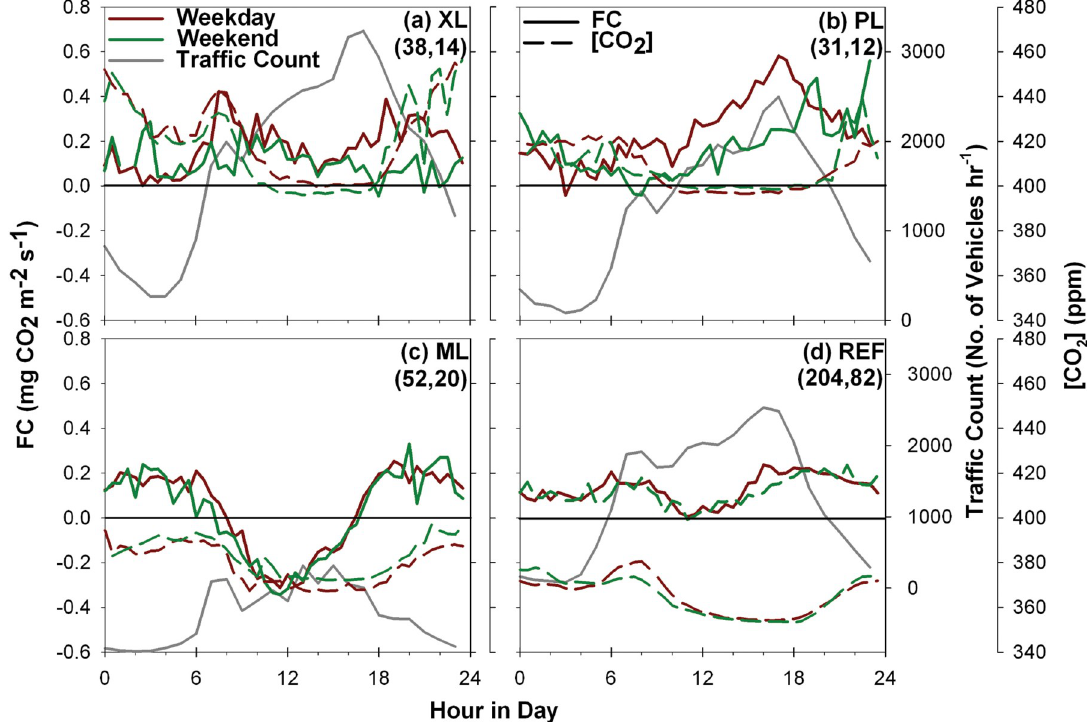
Fig 6. Diurnal averages of FC for weekday and weekend days. Comparison of the average diurnal cycles of carbon dioxide flux for weekday and weekend days for the (a) XL, (b) PL, (c) ML, and (d) REF sites, including traffic counts from nearby streets. Parentheses indicate the number of days in each category of weekday and weekend for each site, respectively. Different sampling periods are specified in each plot.